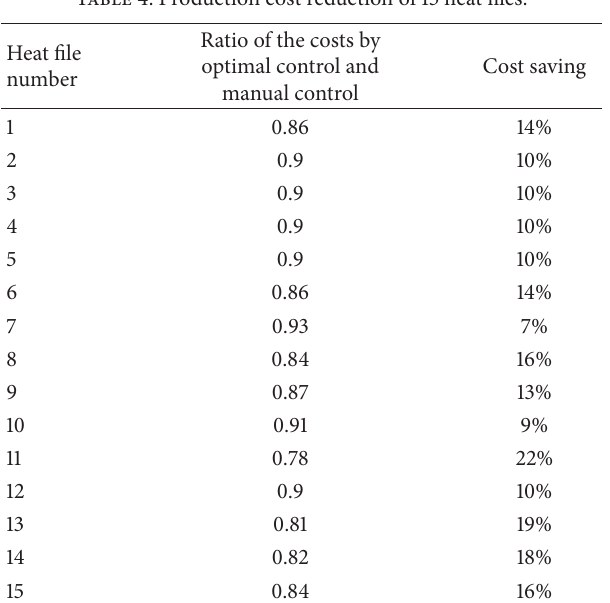
Table 4: Production cost reduction of 15 heat